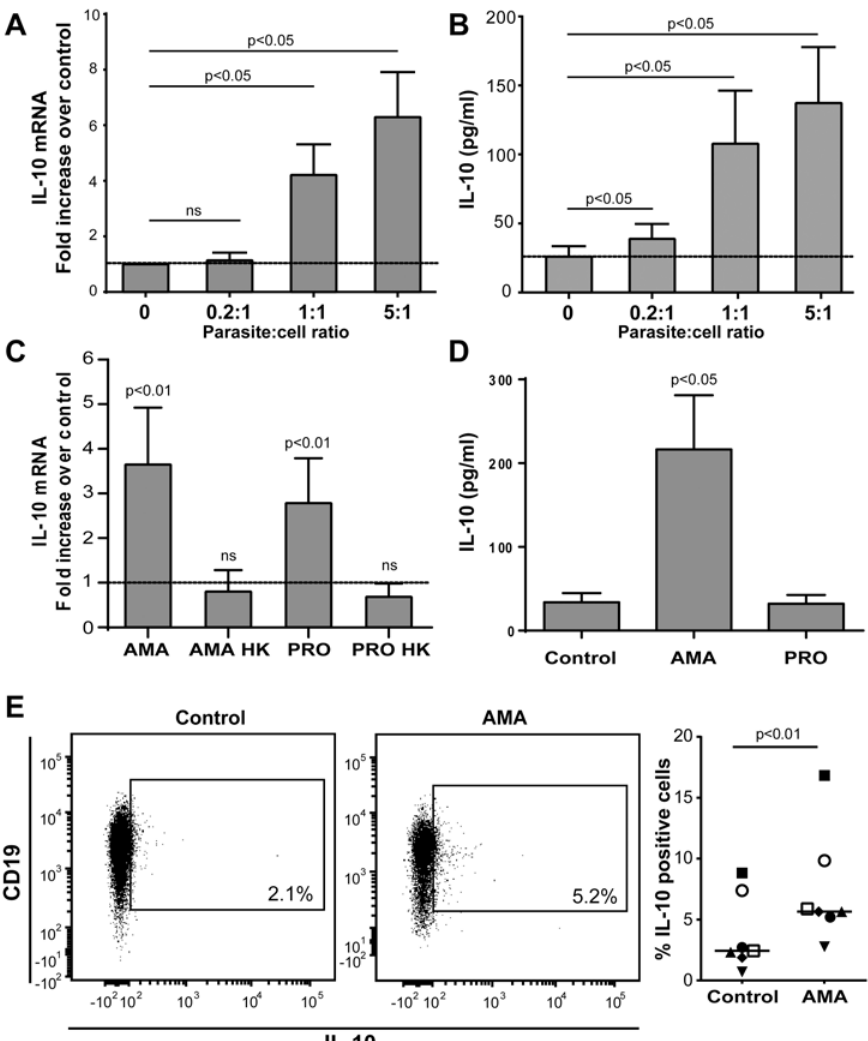
Fig 2. Incubation of human B cells with L . infantum amastigotes induces IL-10 production. A) Purified human B cells were either left alone (used as a control) or incubated overnight with L . infantum amastigotes at the listed parasite:host cell ratios. Next, IL-10 mRNA expression was measured by quantitative real-time PCR. Results are expressed as fold increase relative to cells left alone. P values were calculated by two- tailed Student ’ s t-test (n = 5). B) Cells were treated as in a panel A and IL-10 secretion was measured in cell- free supernatants by ELISA. Results are expressed as means +/- standard errors of the means (SEM) and P values were calculated by two-tailed Student ’ s t-test (n = 7). C) Purified human B cells were incubated overnight either with live L . infantum amastigotes, heat-killed (HK) L . infantum amastigotes, live L . infantum promastigotes (PRO), or heat-killed L . infantum promastigotes at a final parasite:host cell ratio of 3:1 before assessing IL-10 mRNA by quantitative real-time PCR. Results are expressed as fold increase relative to cells left alone. P values were calculated by two-tailed Student ’ s t-test (n = 5). D) Purified human B cells were incubated overnight either with live L . infantum amastigotes or live L . infantum promastigotes at a final parasite:host cell ratio of 3:1 before testing IL-10 production by ELISA. Results are expressed as means +/- SEM and P values were calculated by two-tailed Student ’ s t-test (n = 7). E) A representative dot plot of IL-10- expressing CD19 + B cells either left alone or incubated with L . infantum amastigotes (AMA) is shown on the left portion while percentages of IL-10-positive cells are displayed on the right portion of the panel. Results are expressed as means +/- SEM and P value is calculated by two-tailed Student ’ s t-test (n =